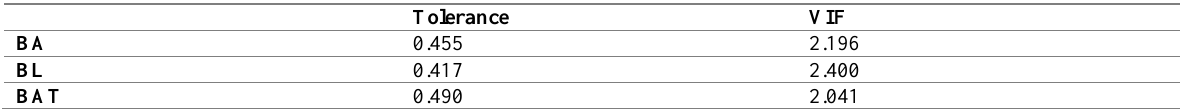
Table 4: Multicollinearity diagnostic (Model)